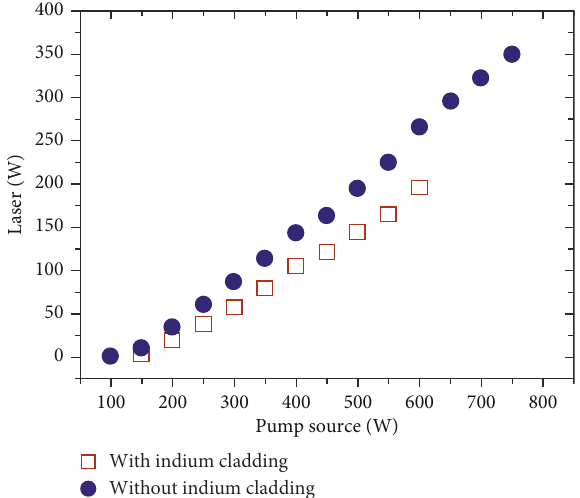
Figure 11: The simulated central temperature rise caused by the heat transfer. Figure 12: The laser output before and after